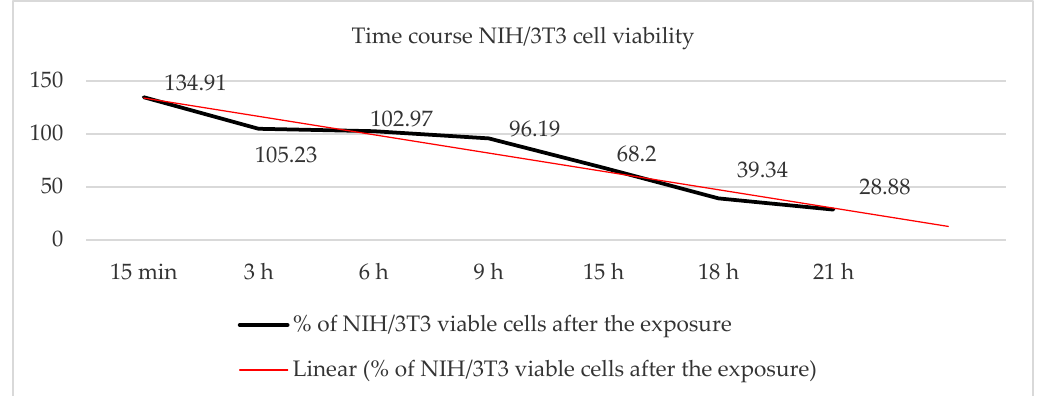
Figure 5. Percentage of viable NIH/3T3 cells after exposure to a radio frequency (RF)-EMF of 56.20 µW/cm 2 at 2.54 GHz for 15 min, 3 h, 6 h, 9 h, 18 h and 21 h.